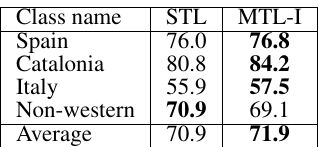
Table 3. F1-Scores [%] for the task production timespan (first series of experiments).